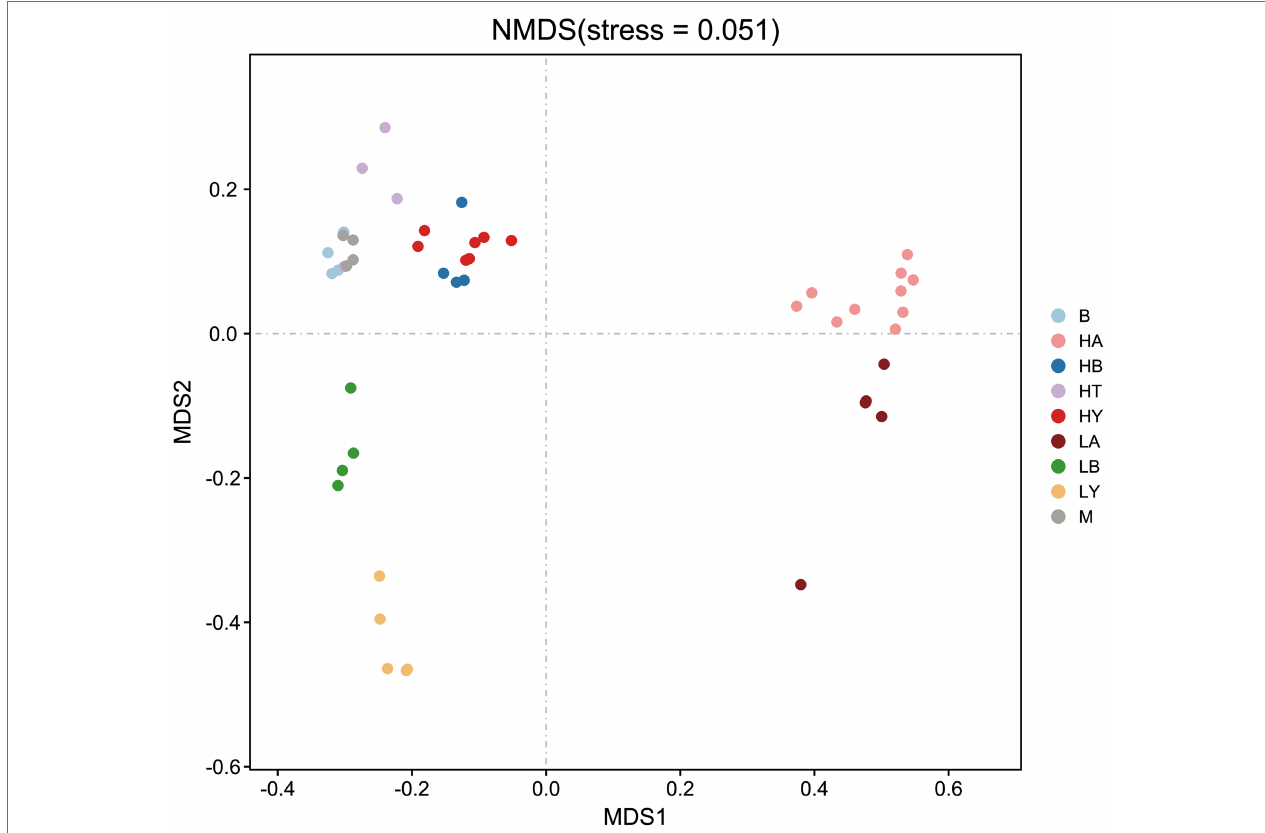
FIGURE 4 | Non-metric multidimensional scaling (NMDS) of gut microbiome composition. Each symbol represents the gut microbiome of a group. HA, high- altitude Tibetan wild ass; HB, high-altitude blue sheep; HT, high-altitude Tibetan antelope; HY, high-altitude yak; LA, low-altitude Tibetan wild ass; LB, low-altitude blue sheep; LY low-altitude yak. B, blue sheep from Xining wildlife zoo, M, European Mouflon from Xining wildlife zoo.